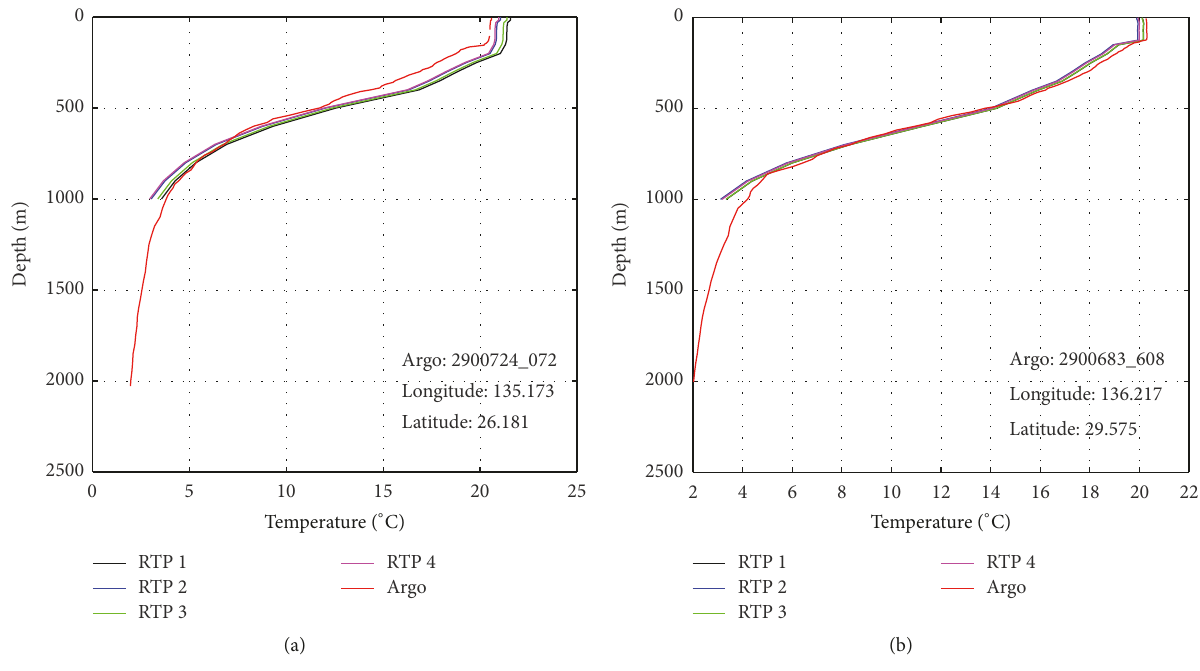
Figure 5: Two samples of reconstructed RTP and the corresponding Argo temperature